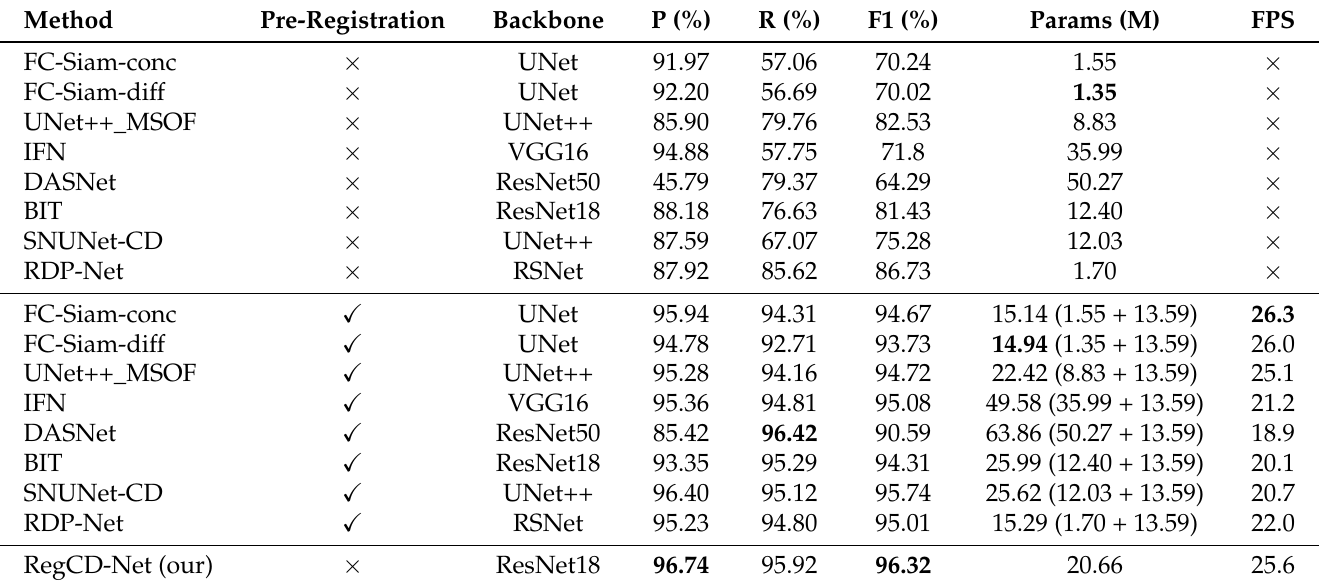
Table 2. Performance comparison results on our dataset. The parameters of different methods with pre-registration contain the parameters of GLU-Net (13.59 M). The FPS is computed by adding the registration speed of GLU-Net and the detection speed of different